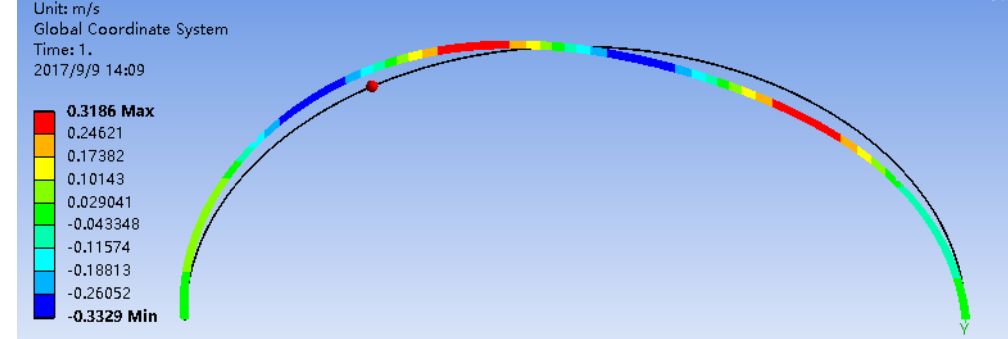
Figure 14. The velocity response in the y-direction of the circular shell when t = 1.0 s.